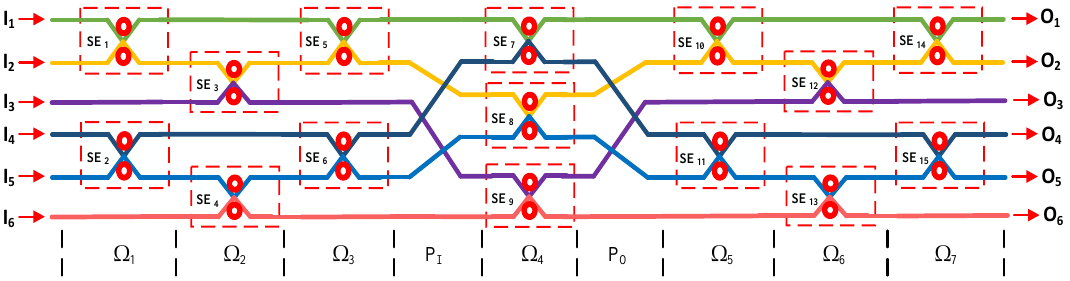
Figure 3. 6×6 Optical switch architecture with all 15 OSEs in drop/bar state . Figure 3. 6 × 6 Optical switch architecture with all 15 OSEs in drop / bar